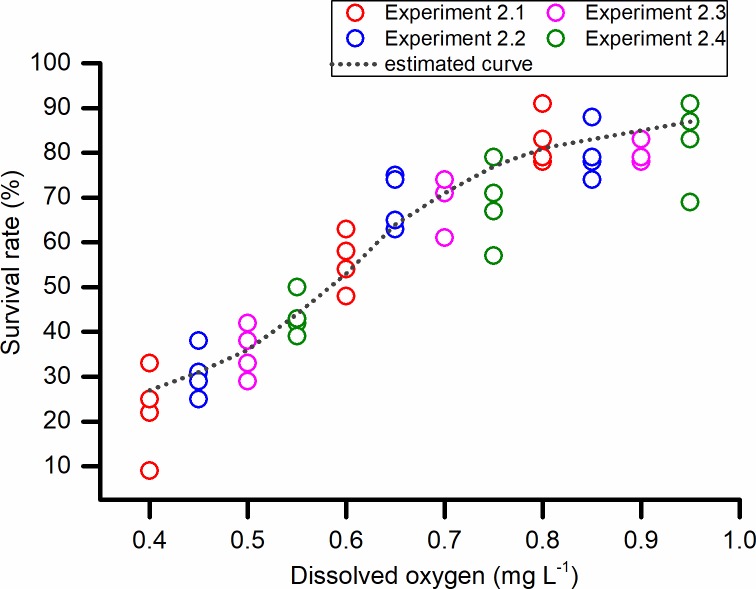
Survival rates of the Ruditapes philippinarum in Experiment 2.Each circle represents one replicate in one specific experiment. The 20-day LC50 for DO was estimated by probit analysis, based on the combined results of Experiments 2.1–2.4. N = 96 per treatment.